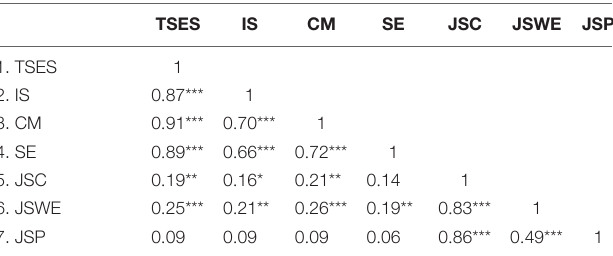
TABLE 4 | Pair-wise correlations between the TSES and